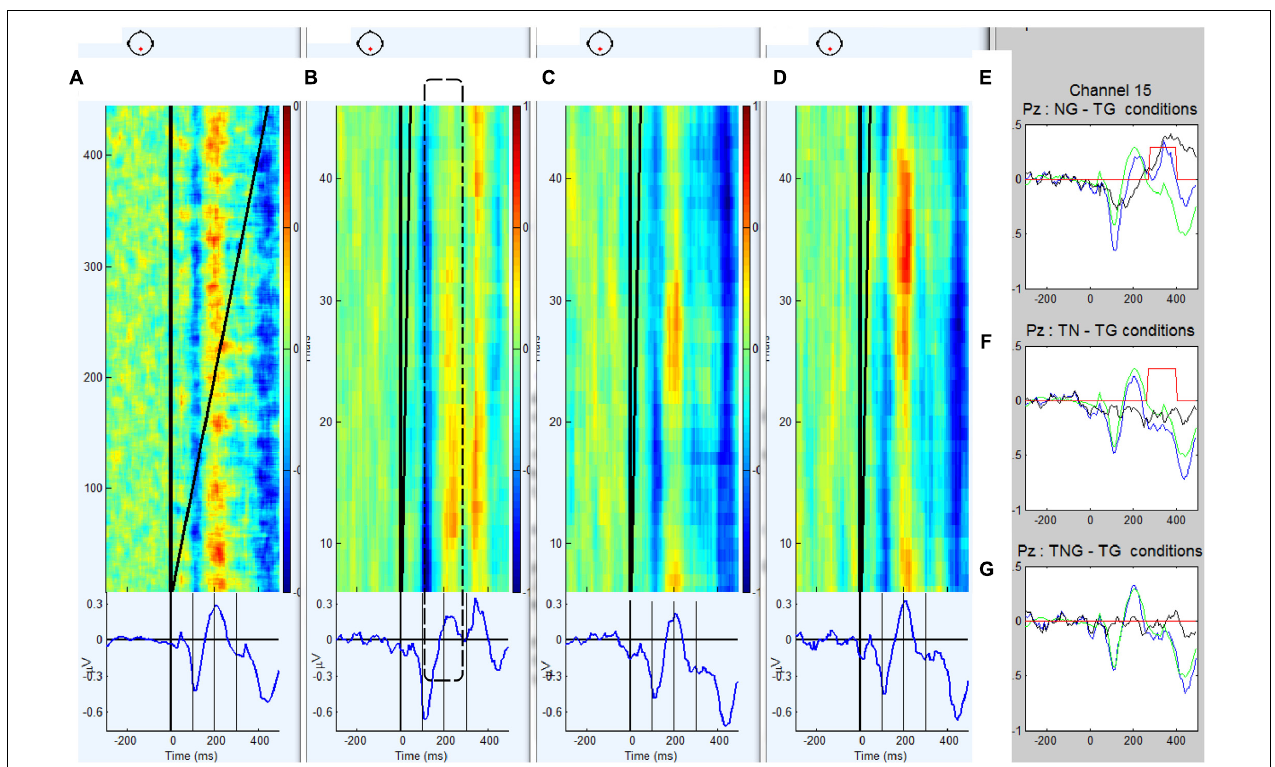
FIGURE 4 | (A–D) Grand average ERP waveforms and trial by trial voltage plots at Pz electrode in 12 participants diagnosed with schizophrenia in the standard goal (TG), novel preceding goal (NG), novel target (TN) and simultaneous novel and goal (TNG) conditions. (E–G) Waveforms generated by subtraction (in black) of novel conditions from control condition (TG in green) and corresponding t -values for successive time bins of 187.5